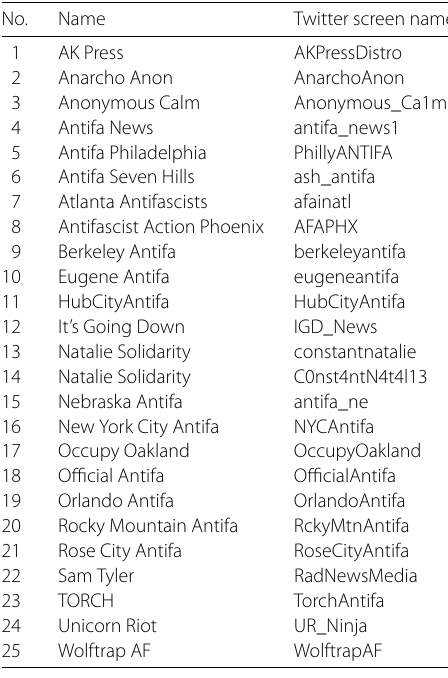
Table A2 List of Antifa groups in U.S. who have active Twitter account on December 2017 No.